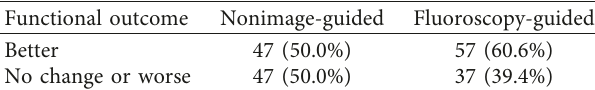
Table 3: Comparison of subjective functional outcome changes between blind and fluoroscopy-guided lumbar interlaminar epi- dural block in the same individuals.